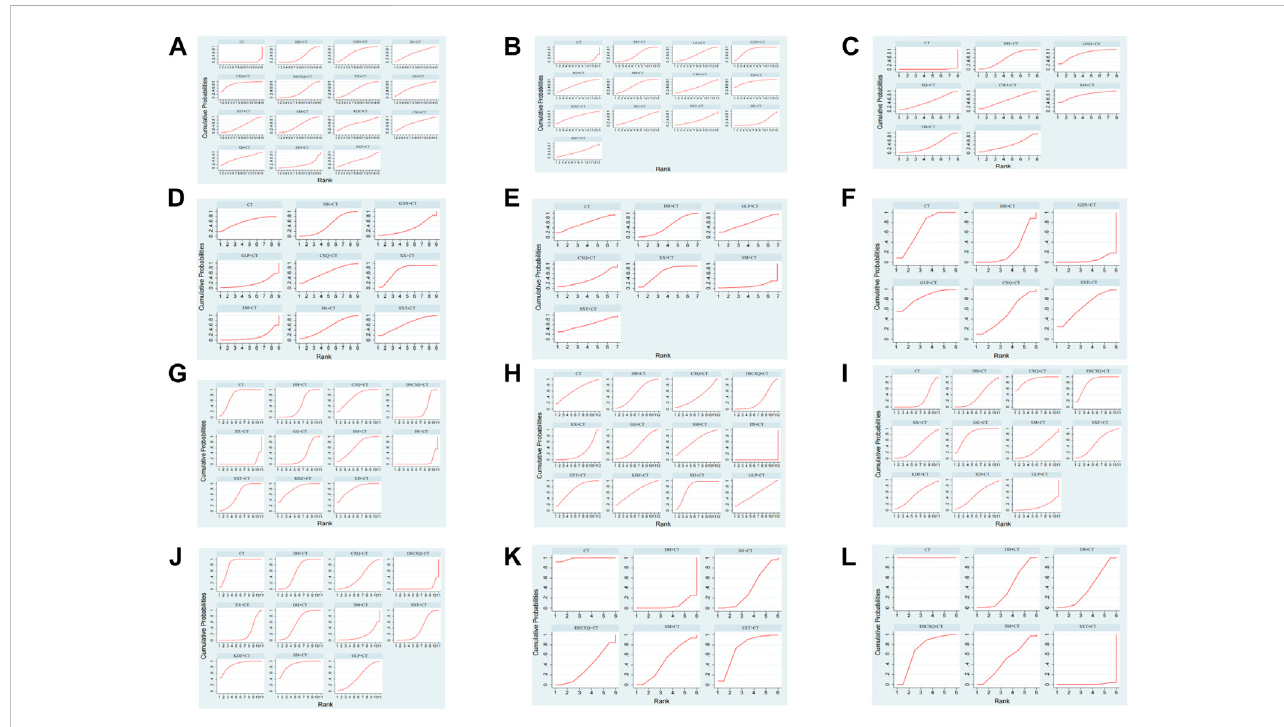
FIGURE 5 Ranking probabilities of comparable treatments. (A) Total effective rate; (B) EGG effective rate; (C) Effective rate of angina pectoris; (D) FBG; (E) PBG; (F) HbA1c; (G) TC; (H) TG; (I) HDL; (J) LDL; (K) Frequency of angina pectoris; (L) Duration of angina pectoris.